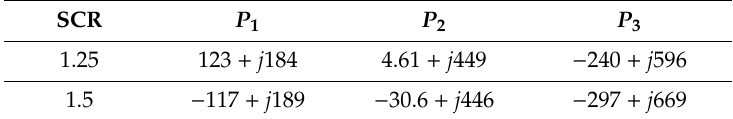
Table 1. Poles for short circuit ratio (SCR) variations for X g / R = 20 and X c / X g = 0.